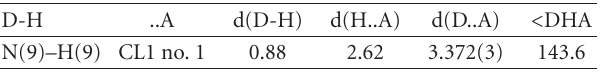
Table 9: Antineoplastic activity in human colon tumor cell lines (HCT116) by growth inhibition SRB assay after 96-hour